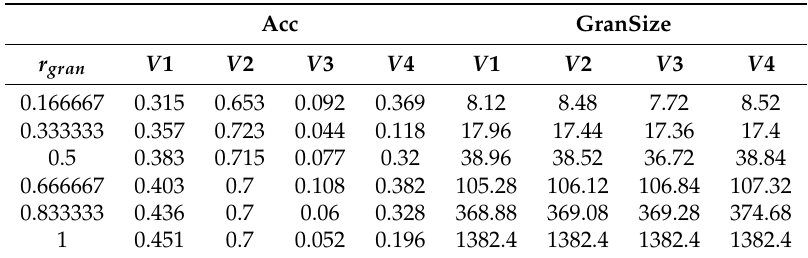
Table 22. 5 × CV-5; The result of experiments for four variants of the Naive Bayes classifier; data set Car evaluation; concept dependent granulation; r gran = Granulation radius; nil = result for data without missing values; Acc = Accuracy of classification; GranSize = The size of data set after granulation in the fixed r .